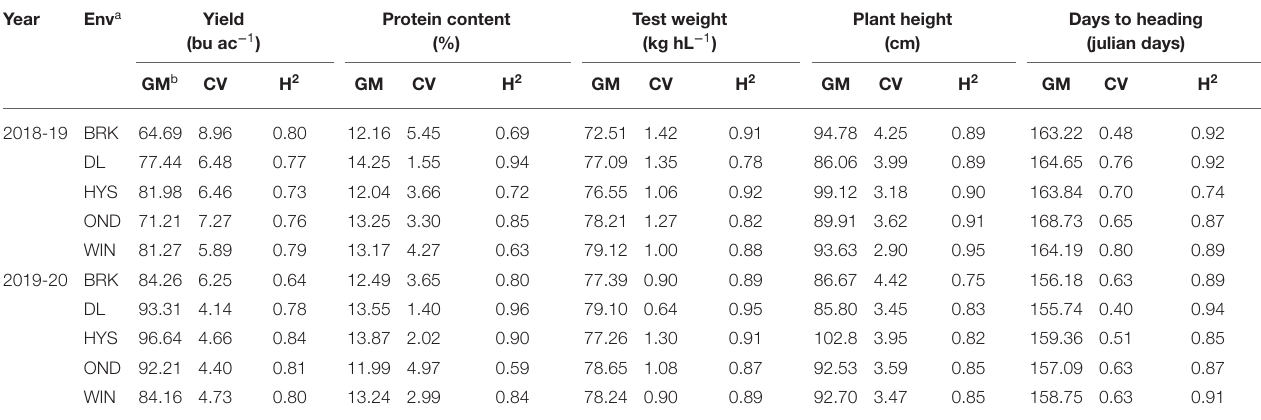
TABLE 1 | Trait descriptive statistics and broad-sense heritability estimate for individual site-year environments of lines grown over five locations (Env) in 2018–19 and 2019–20 growing seasons. Year Env a